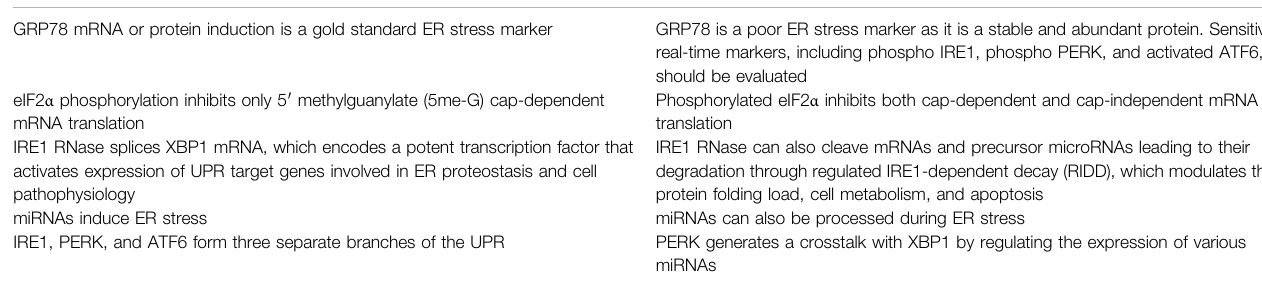
TABLE 3 | Changing views on ER